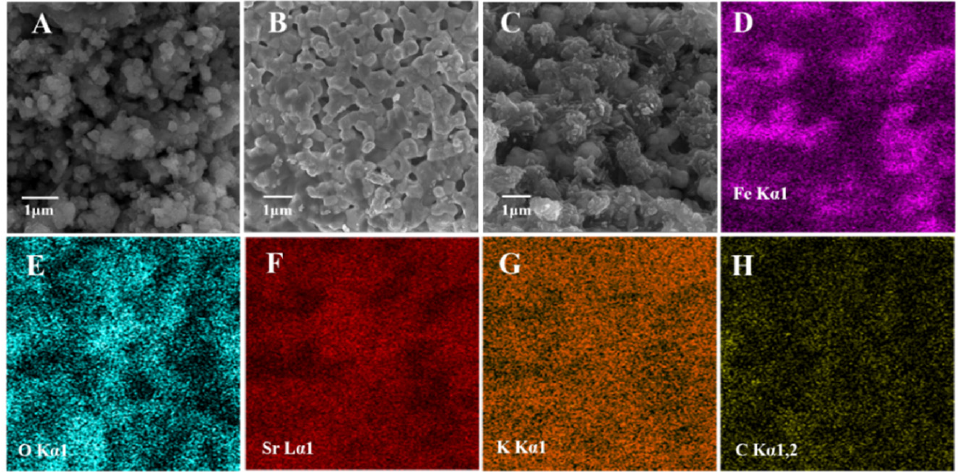
Figure 8. SEM patterns of perovskite catalysts: ( A ) SKF0.0 (fresh); ( B ) SKF0.4 (fresh); ( C ) SKF0.4 (after reaction). ( D – H ) EDS mapping.